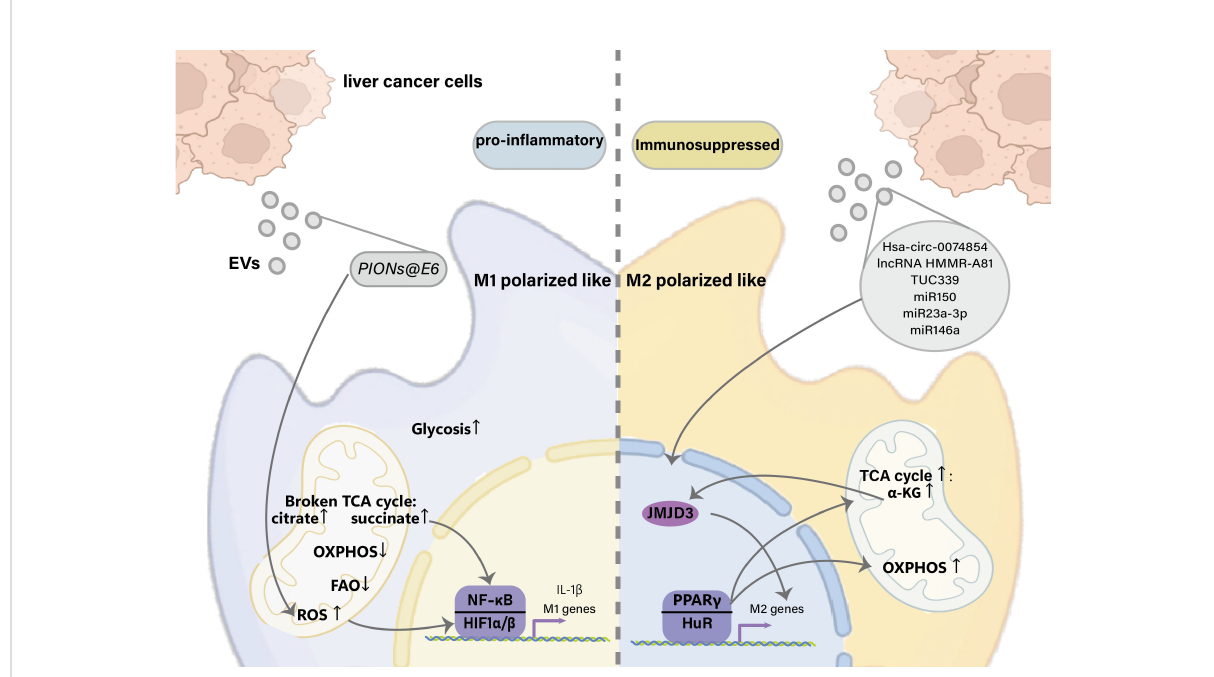
FIGURE 2 Effects of liver cancer-derived exosomes on macrophage polarization. EVs, Extracellular vesicles; TCA, tricarboxylic acid cycle; OXPHOS, Oxidative phosphorylation; FAO, Fatty Acid Oxidation; HIF1, hypoxia-inducible factor 1; NF- k B, Nuclear factor kappa-light-chain-enhancer of activated B cells; IL-1 b , Interleukin 1 beta; a -KG, a -Ketoglutaric acid; JMJD3, Jumonji domain-containing protein-3; PPAR g , Peroxisome proliferator-activated receptor g ; HuR, Hu antigen